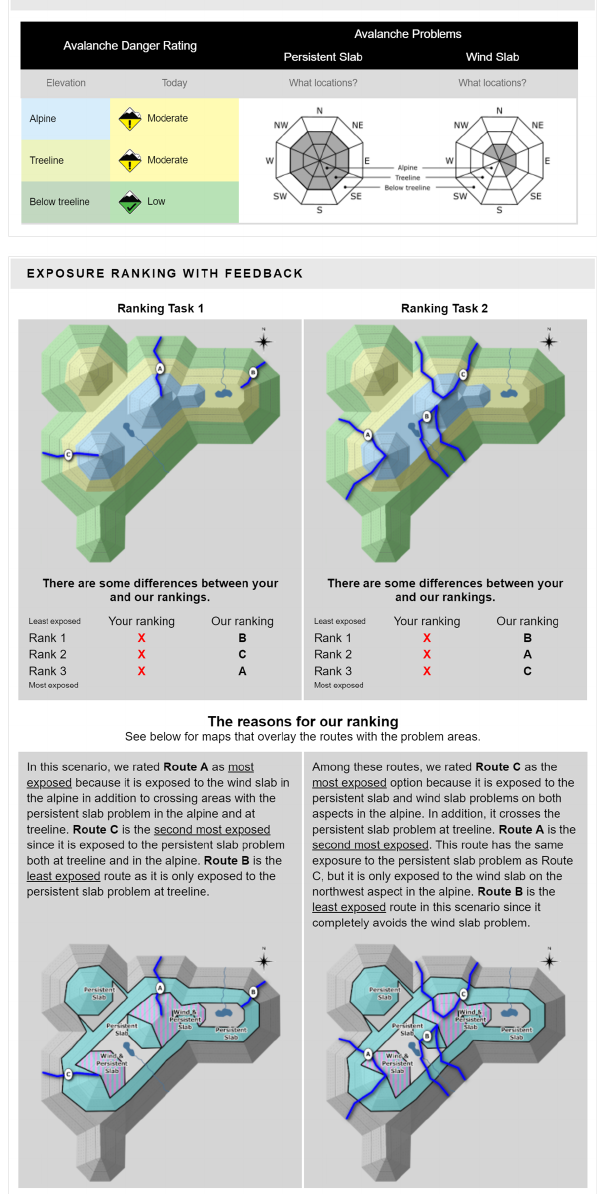
Figure A1. Screenshot of scenario 1 (ID 1) with avalanche bulletin information, route options, ranking solutions, and